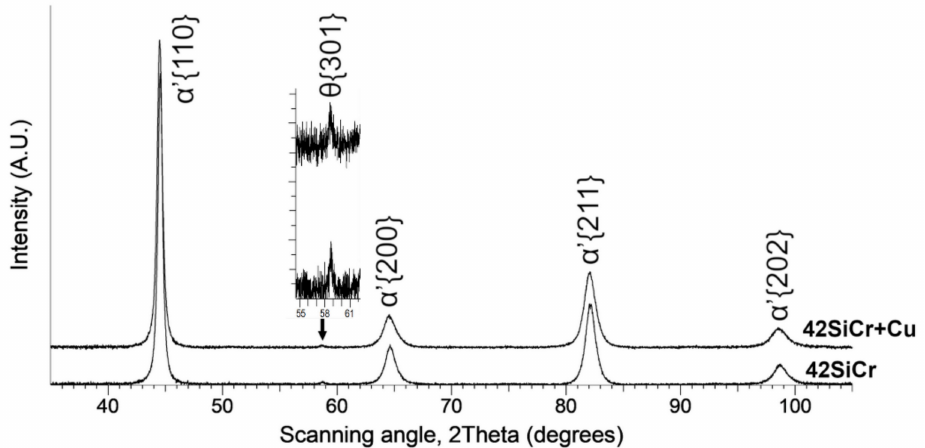
Figure 2. XRD patterns of 42SiCr and 42SiCr + Cu steels after